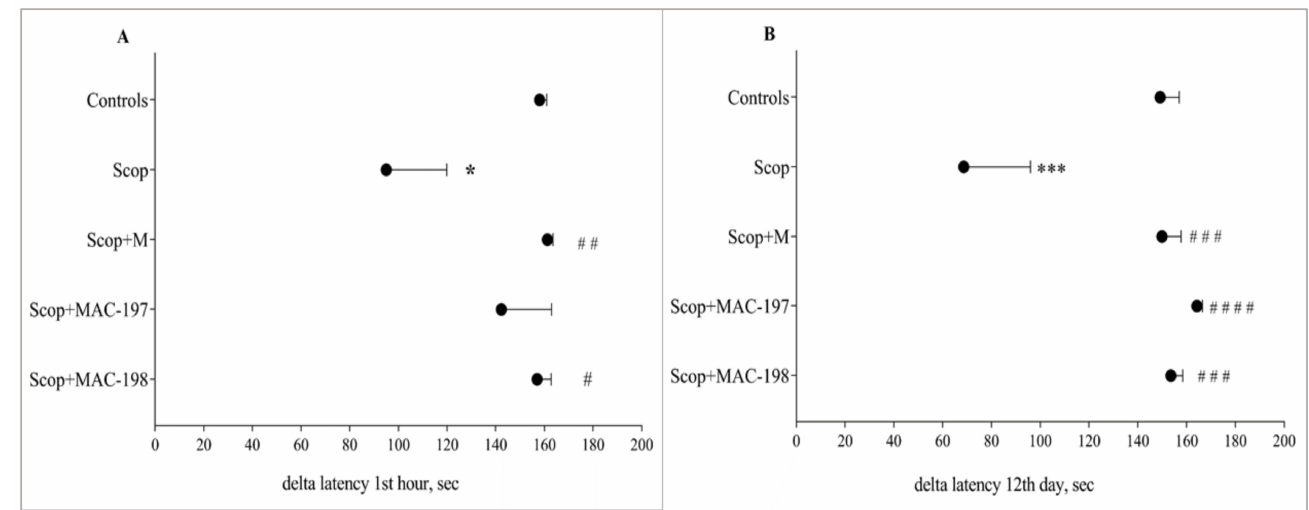
Figure 4. Effects of MAC-197 and MAC-198 on short-term ( A ) and long-term ( B ) memory performance in rats with scopolamine-induced dementia; M (40 mg/kg) was used as a referent; data are expressed as the mean ± SEM ( n = 10). * p < 0.05, *** p < 0.001 vs. Controls; # p < 0.05, # # p < 0.01, # # # p < 0.001, # # # # p < 0.0001 vs. scopolamine (Scop) group.